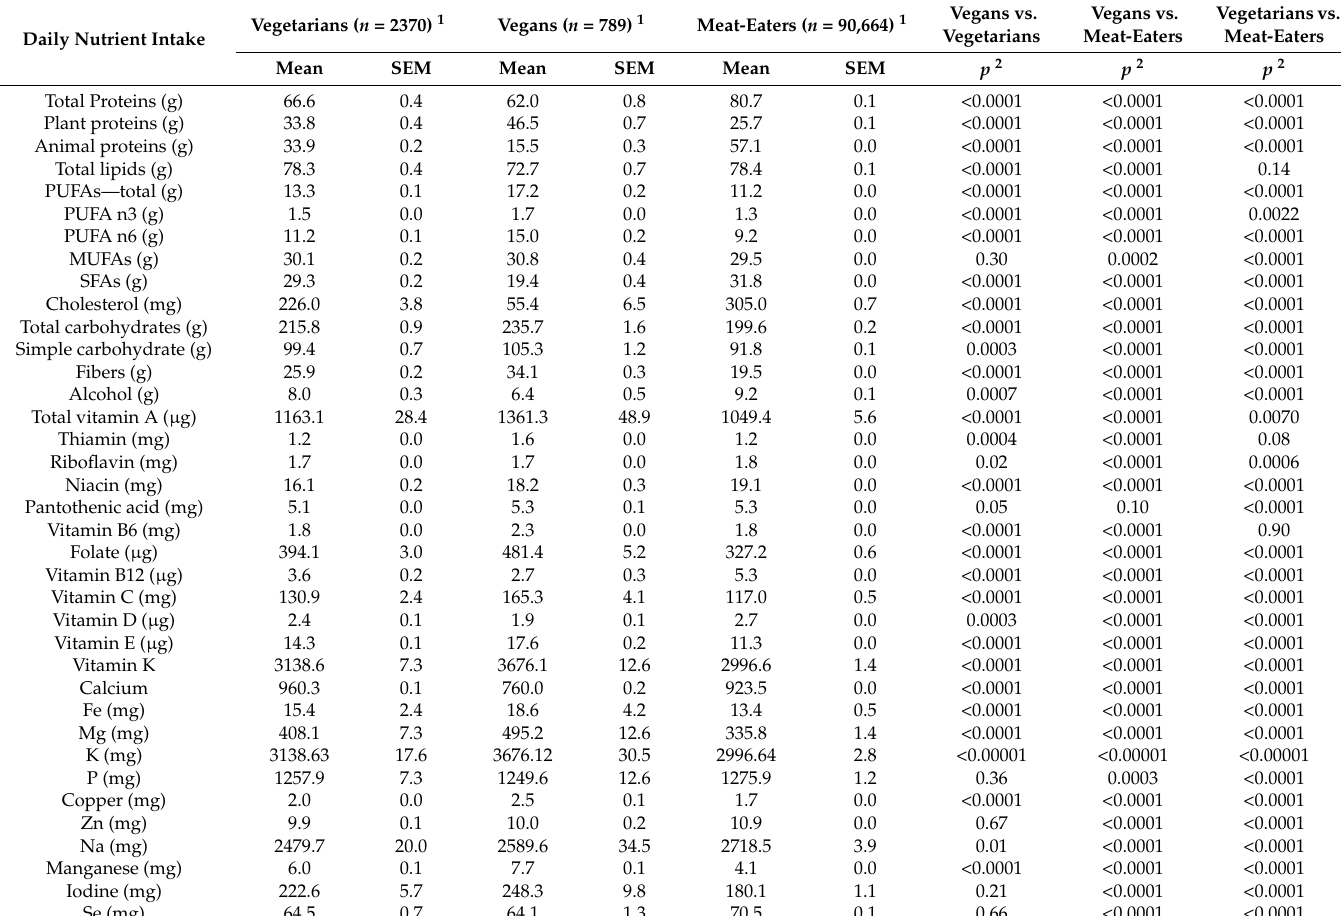
Table 4. Mean nutrient intake adjusted for age and sex among vegetarians, vegans, and meat-eaters (Nutrinet-Sant é Study 2009–2015, n =